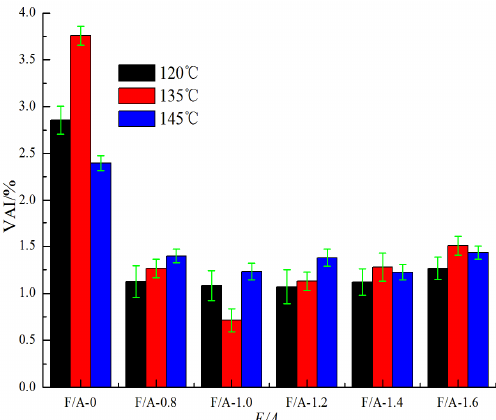
Figure 7. Value of base asphalt mortar.